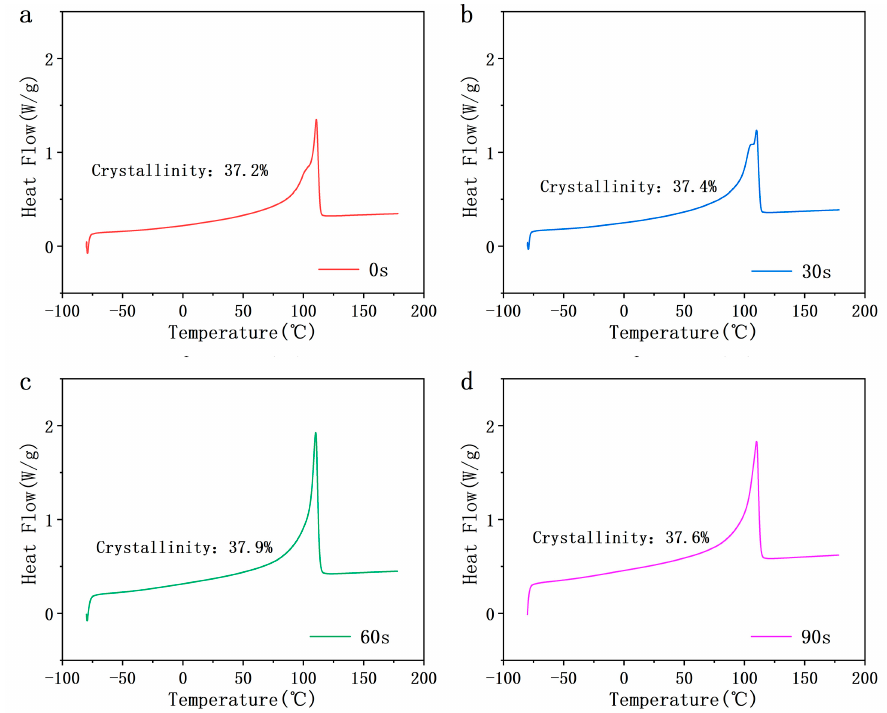
Figure 6. DSC endothermic diagrams of ZnO/LDPE films prepared by different plasma-treatment times: ( a ) 0 s; ( b ) 30 s; ( c ) 60 s; and ( d ) 90 s.